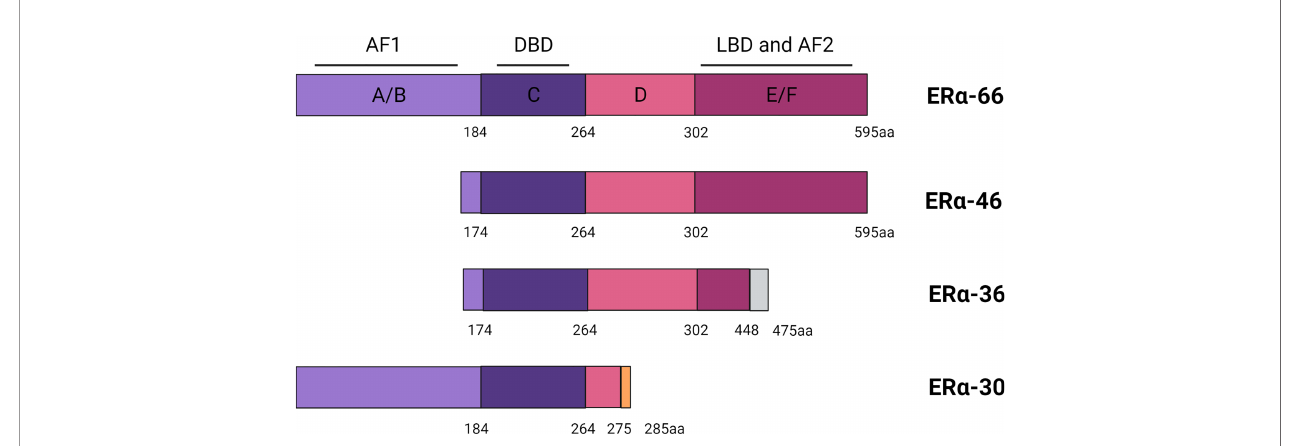
FIGURE 1 | Scheme of ER a , ER a -46, ER a -36 and ER a -30